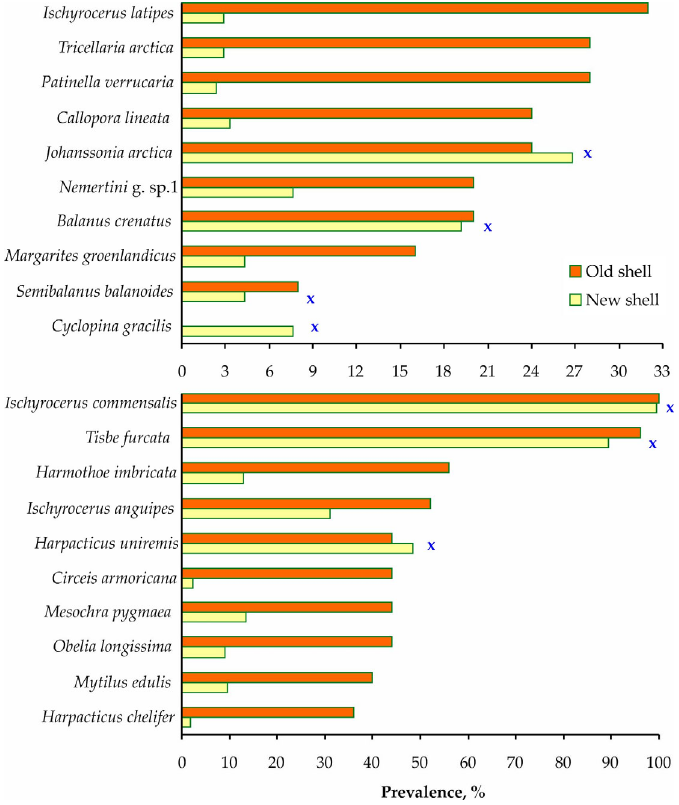
Figure 6. Total infestation prevalence on adult red king crabs with new and old shells in Dalnezelenetskaya Bay in summers during the period 2009–2013. X indicates insignificant differences (Chi-squared test, p > 0.05). Table 3. Diversity indices of fauna associated with red king crabs in the coastal Barents